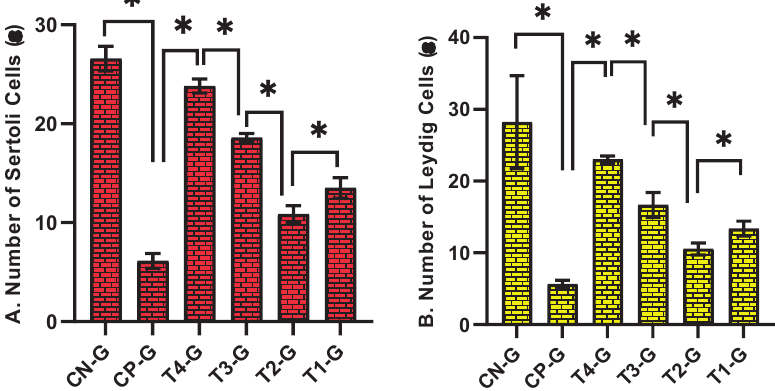
Figure 1. A. Number of Sertoli Cells. B. Number of Leydig Cells in each group. Post Hoc analysis: * p<0.05